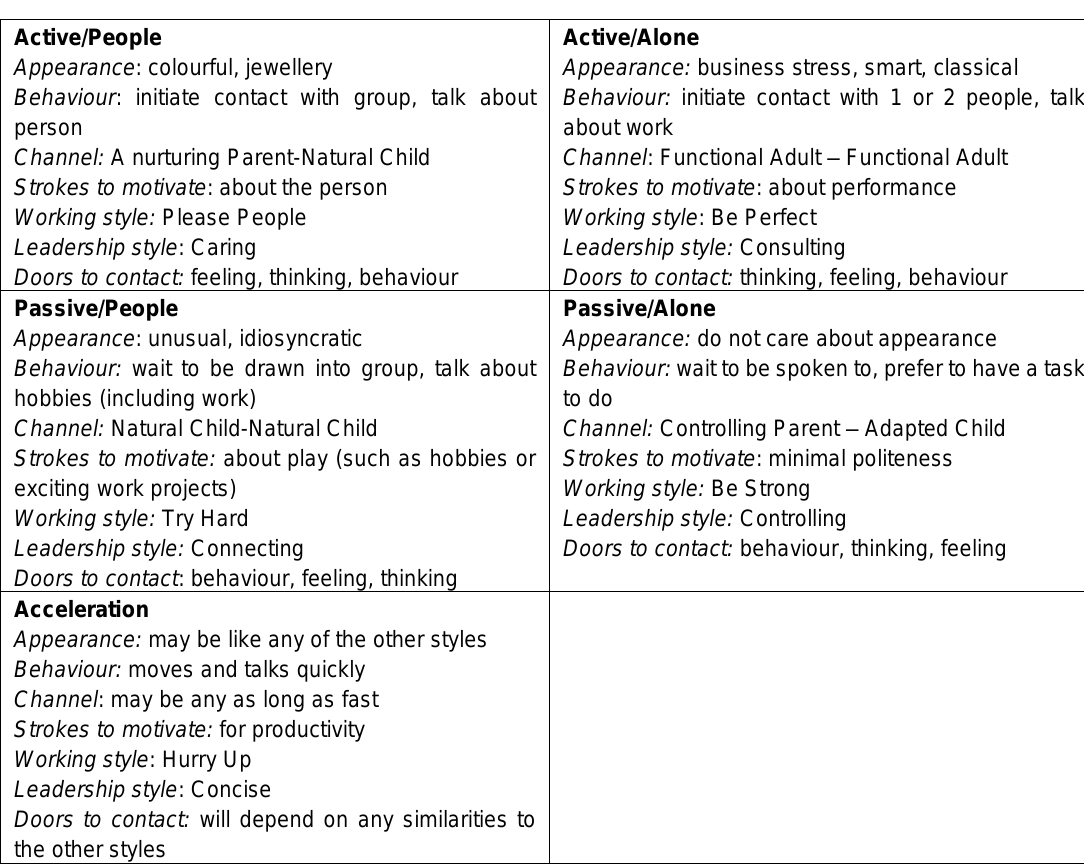
Table 6: AP3 Summary - amended from Hay (2012 p. 192 and 193